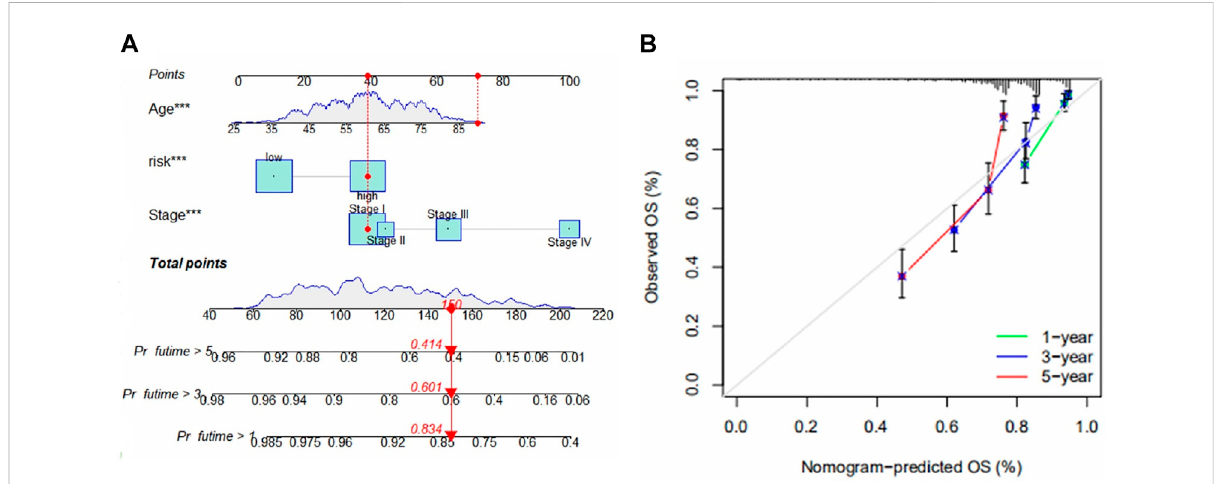
FIGURE 4 (A) Nomogram for predicting 1-, 3-, and 5-year survival for ccRCC. The fi gure shows the predicted results for the 17th patient in the train group.Thispatientbelongstothehigh-riskgroupofpatients,age90,andatstageI.Thescoresofeachindexwere40,70,and40,totalscoresof150, 1-year, 3-year, and 5-year survival rates were 0.834, 0.601 and 0.414. (B) Calibration chart for the evaluation of nomogram